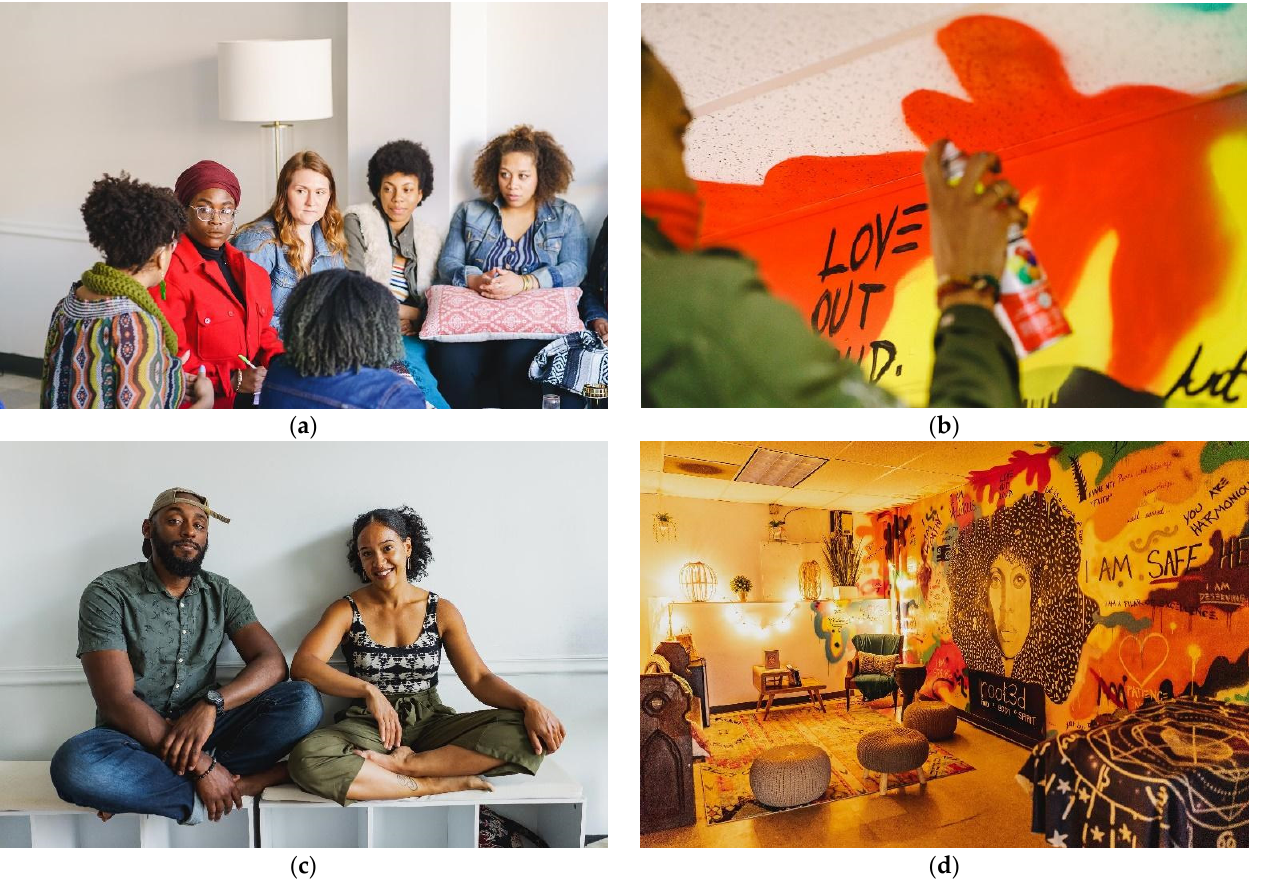
Figure 1. Photos of Root3d, a community healing space centered around black people, indigenous people, and people of color (BIPOC). Photos of Root3d. ( a ) Root3d facilitators practicing ceremony to determine the intention for their classes; photo by Jamel Mosely; ( b ) Local artist Rae Frasier creating a mural that represents communal healing; photo by Jamel Mosely; ( c ) Co-founders Jamel Mosely and Rachelle Pean; photo by Kiki Vassilakis. ( d ) Completed mural by Rae Frasier and Kimberli Gaillard for Root3d, using color, words, symbols, and images to convey community and safety; photo by Kiki Vassilakis.